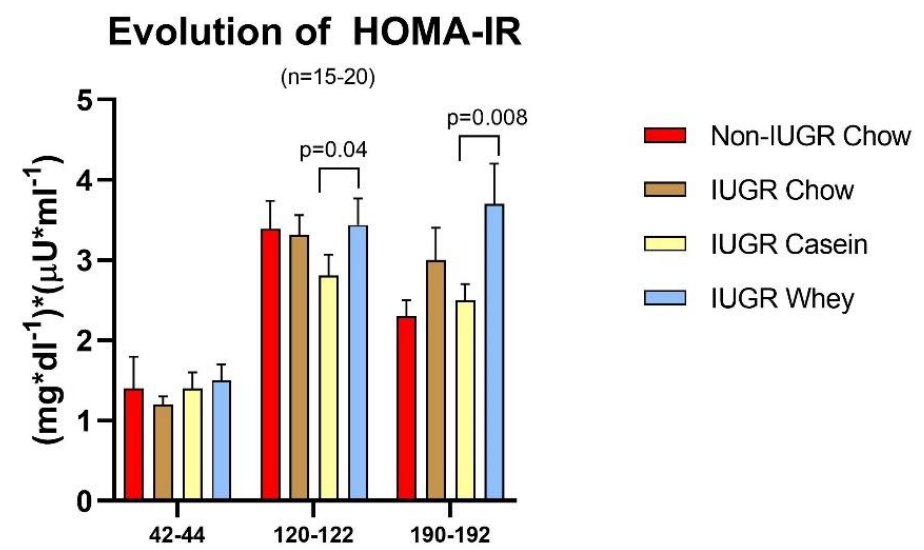
Figure 6. Evolution of homeostatic model assessment of insulin resistance (HOMA-IR) with age ( n = 15–20 per group). Table 4. Blood glucose, plasma insulin, fatty acids, and cholesterol at the end of the study (197–199 days). Leptin FFA TG Total Cholesterol ng / mL µ mol / L mmol / L